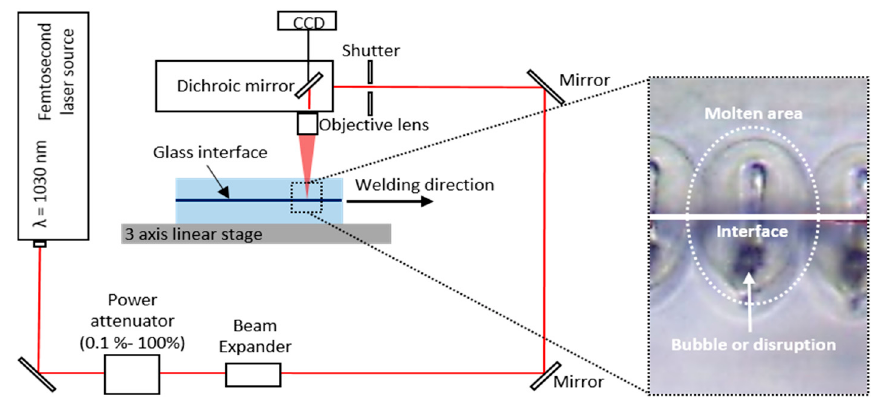
Figure 2. Schematic of laser direct welding experiment setup. The focal position is placed slightly below the interface of two glass substrates and bubbles or disruptions are formed at the position (as shown in the dotted box).